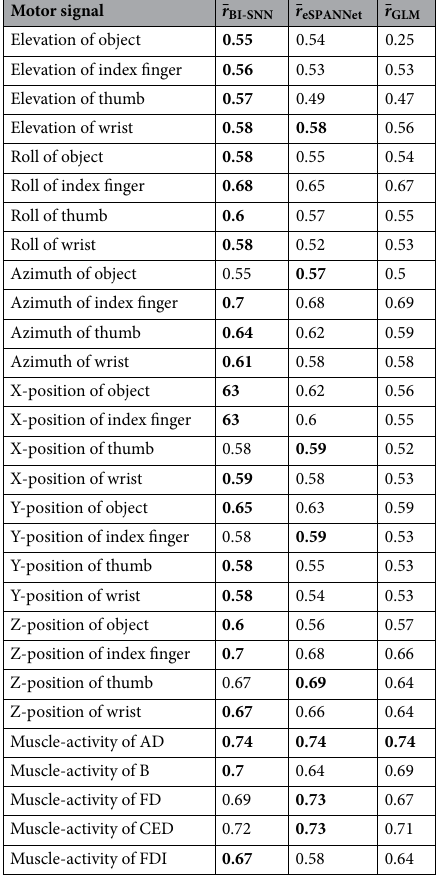
Table 1. Comparison of the average correlation coefficients between the actual and predicted motor signals by BI-SNN, eSPANNet and GLM. The highest average correlation coefficient corresponds to each motor signal is highlighted in bold text. AD anterior deltoid, B brachoradial, FD flexor digitorum, CED common extensor digitorum, FDI first dorsal